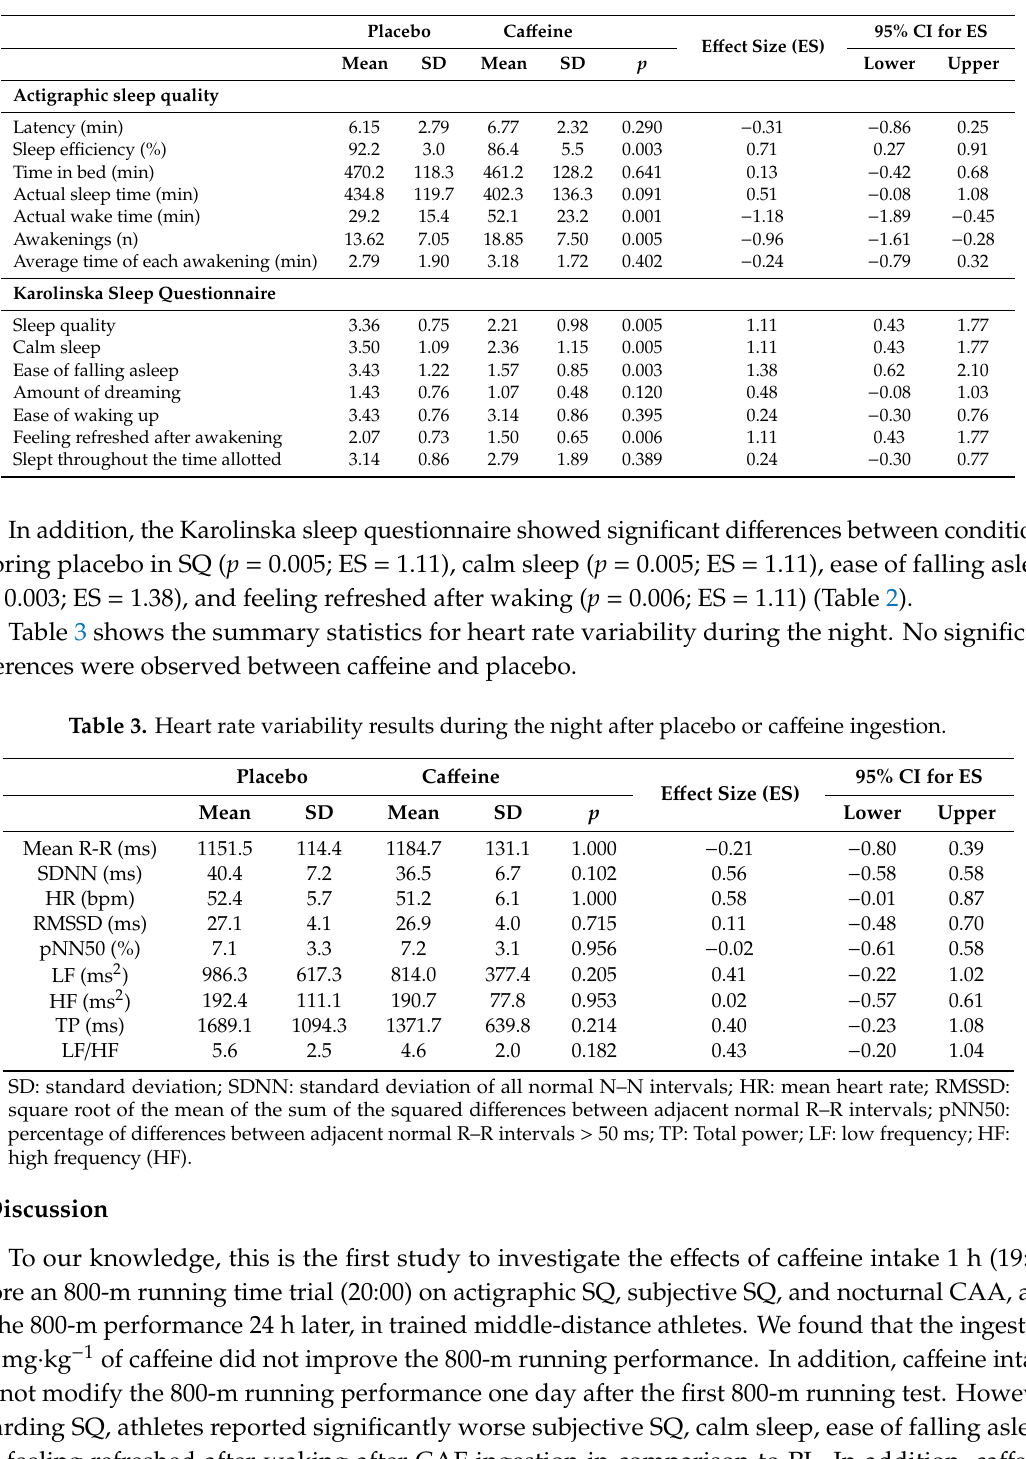
Table 2. Sleep quality results.